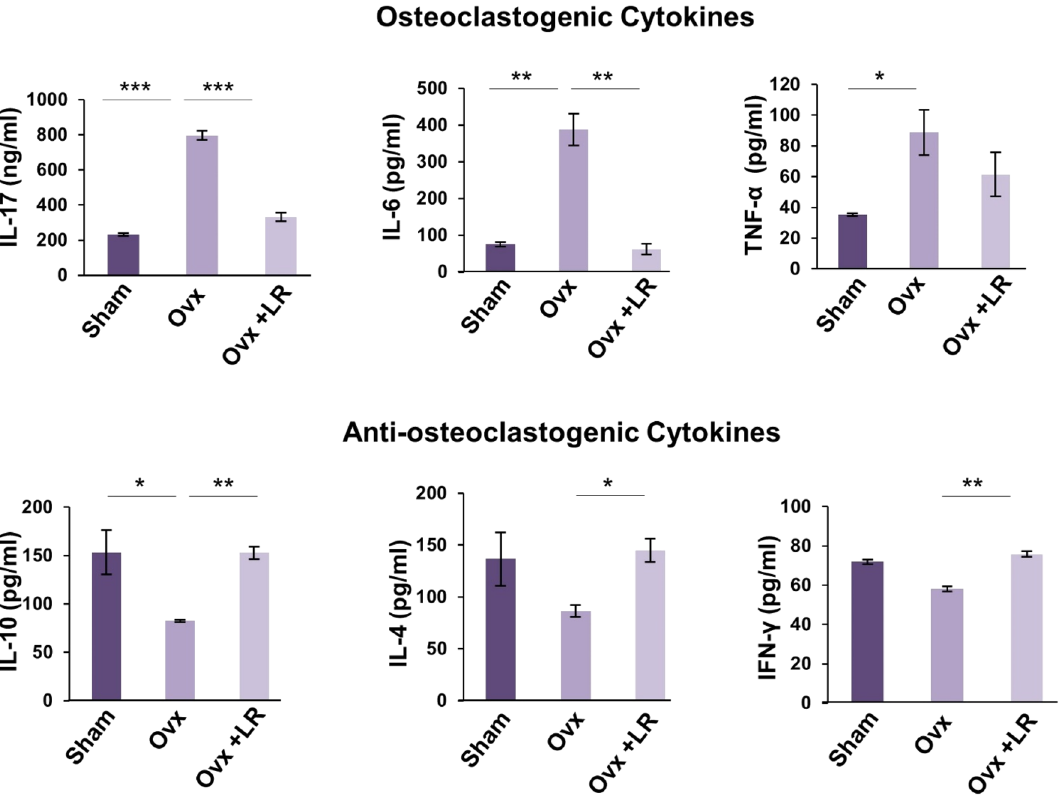
Figure 10. LR skews cytokines balance in Ovx mice. Osteoclastogenic and anti-osteoclastogenic cytokines were analysed in serum samples of mice by ELISA/CBA. The results were evaluated by using ANOVA with subsequent comparisons by Student t-test for paired or non-paired data, as appropriate. Values are expressed as mean ± SEM (n = 6) and similar results were obtained in two independent experiments. Statistical significance was defined as p ≤ 0.05, * p ≤ 0.05, ** p < 0.01 *** p ≤ 0.001 with respect to indicated mice